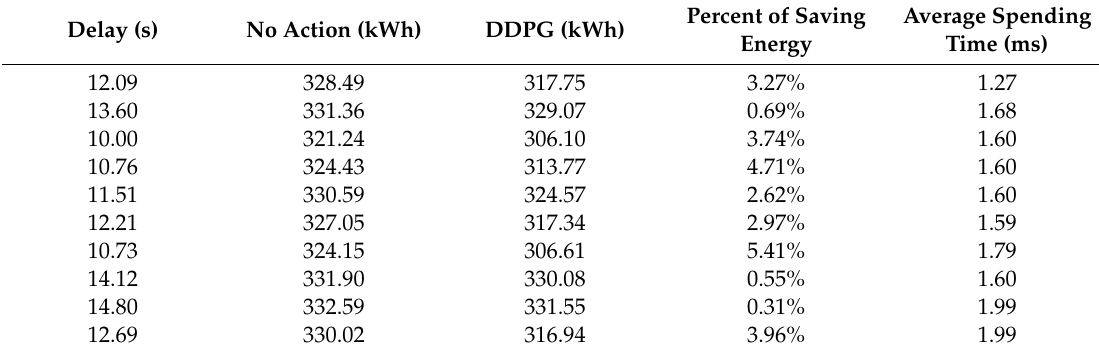
Table 5. Energy consumption and average spending time during the testing process under continuously sampling random disturbances in the two-train network.